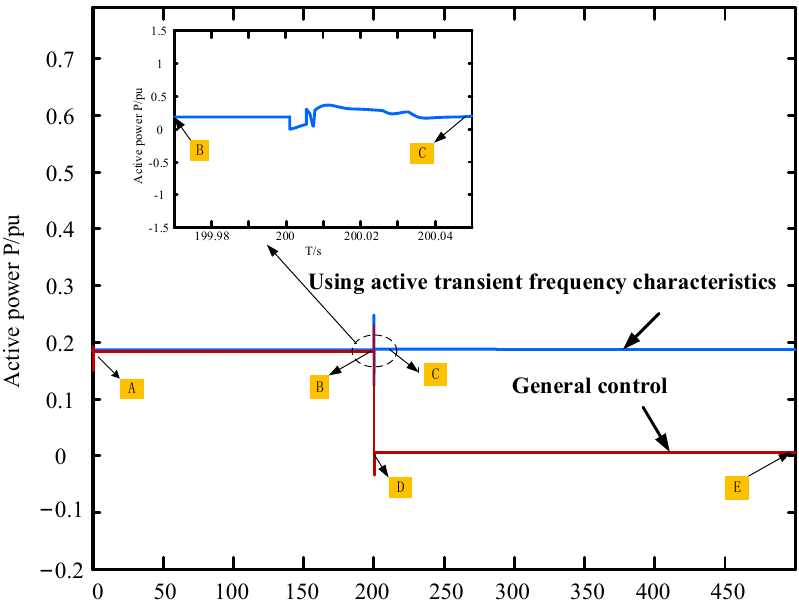
Figure 12. Active ‐ power output diagram of doubly fed induction generator. Figure 12. Active-power output diagram of doubly fed induction